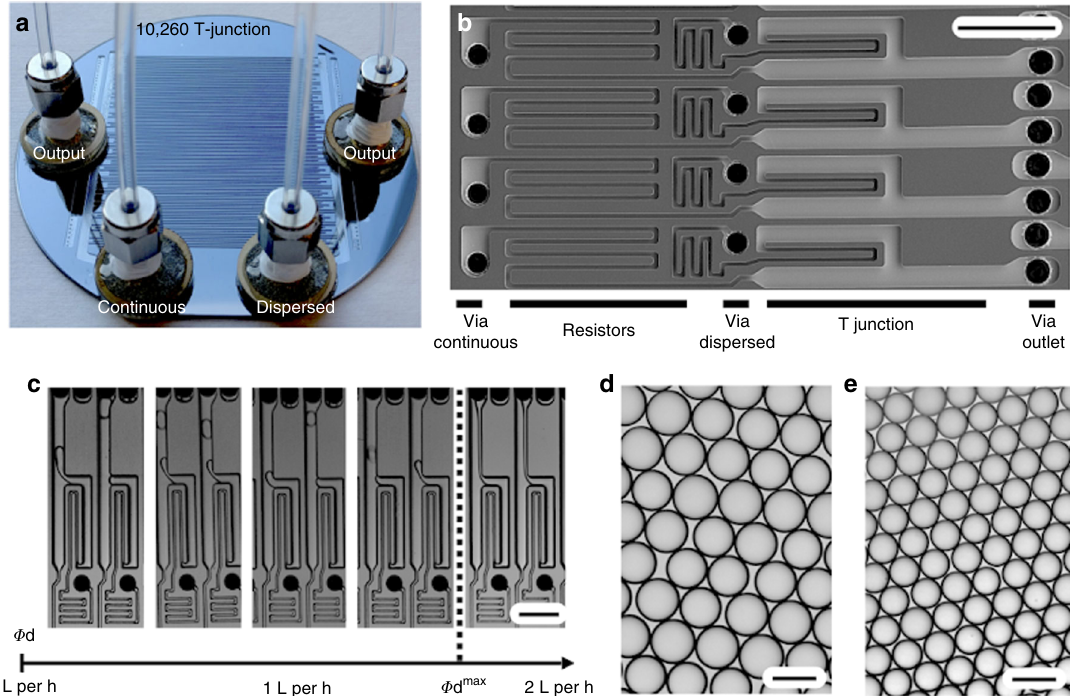
Fig. 4 A VLSDI chip that contains 10,260 (285 × 36) T-junction devices. a A photograph of the T-junction VLSDI chip. b An electron micrograph of four individual droplet generators. Scale bar: 250 µ m. c Optical micrographs of T-junction droplet generators producing hexadecane droplets in water at various dispersed phase fl ow rates ϕ d . The maximum fl ow rate ϕ max possible. Scale bars of all images: 100 µ m. A micrograph of hexadecane droplets in water produced by the T-junction, d which have an average diameter d = 46.2 µ m and a coef fi cient of variation CV = 3.73% and e which have an average diameter d = 33.2 µ m and a coef fi cient of variation CV = 3.27 %. Scale bar: 50 µ